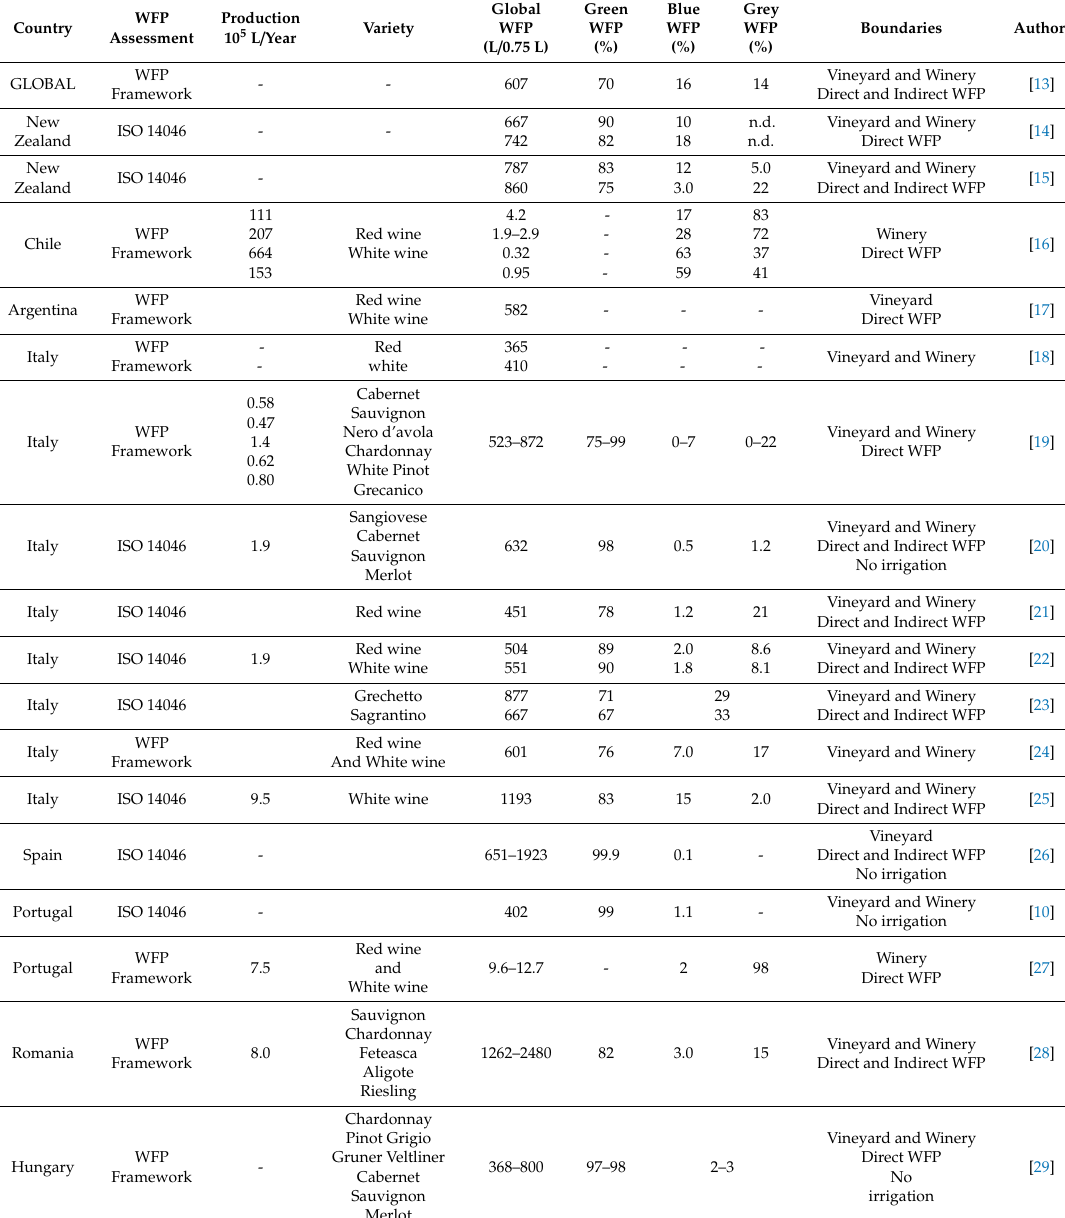
Table 1. Reported studies on wine water footprint (WFP)